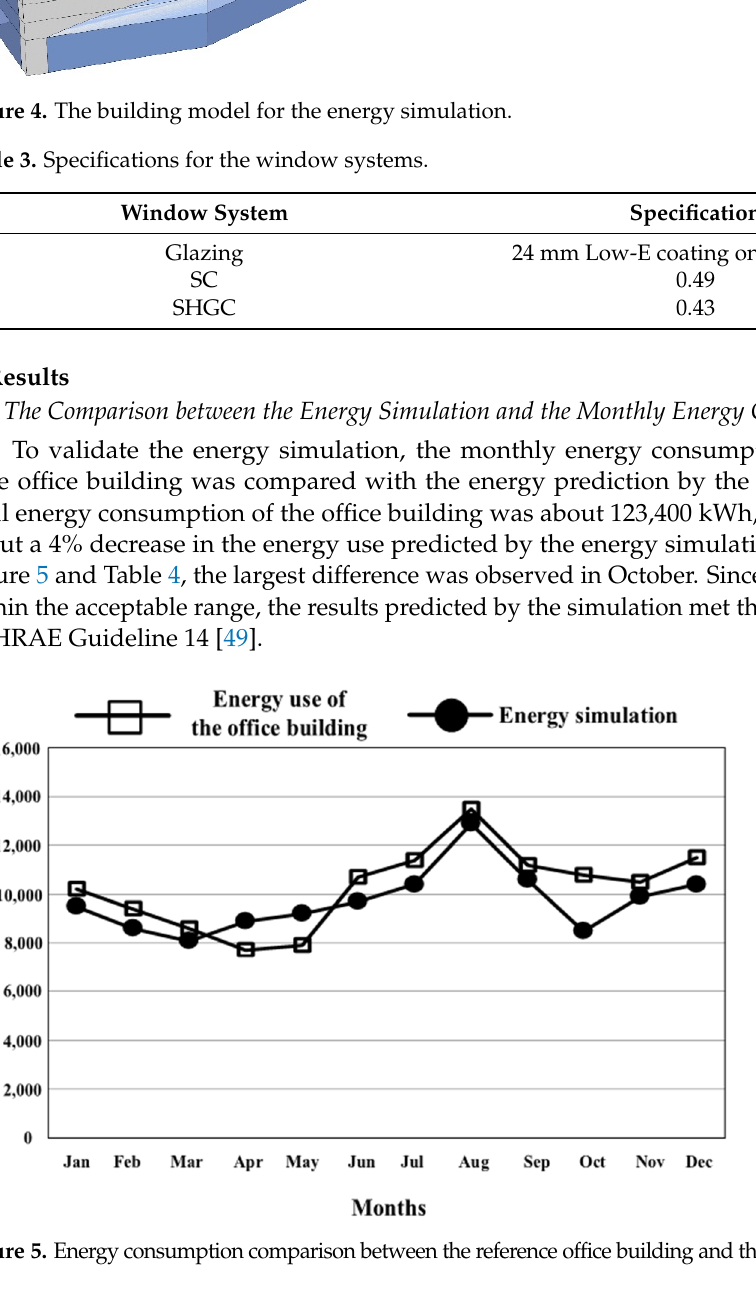
Figure 5. Energy consumption comparison between the reference office building and the energy simulation. Table 4. The monthly energy consumption comparison.